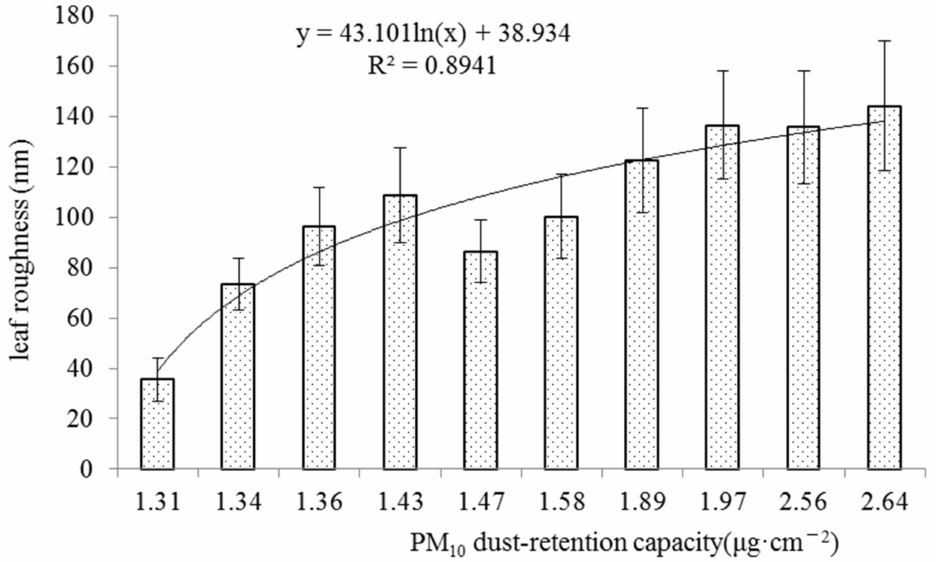
Figure 5. Relationship between PM 10 dust-retention capacity and leaf roughness of different tree